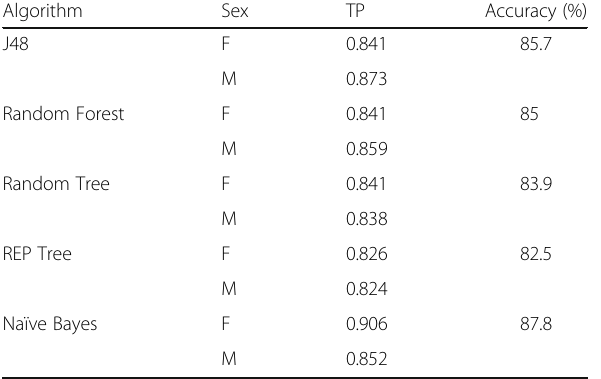
Table 4 Accuracy rates for sex determination through following algorithms using toe length and foot indexes Algorithm